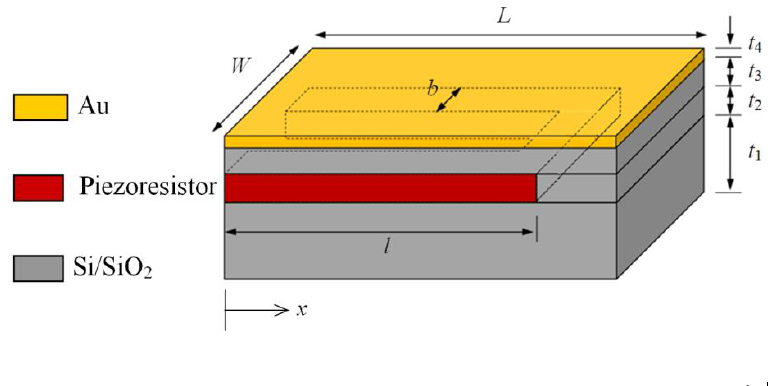
Figure 2. Typical geometry of a 4-layer piezoresistive